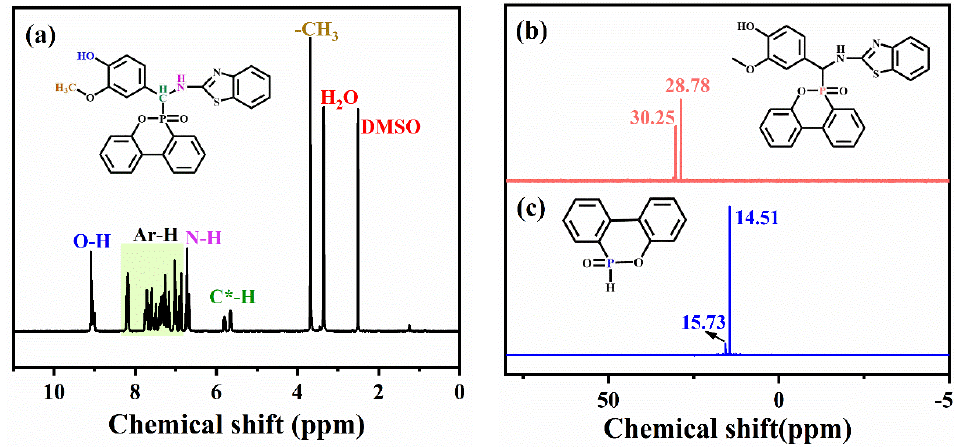
Figure 2. 1 H NMR of AVD ( a ) 31 P NMR of AVD ( b ) and DOPO ( c ), (C* represents chiral carbon).